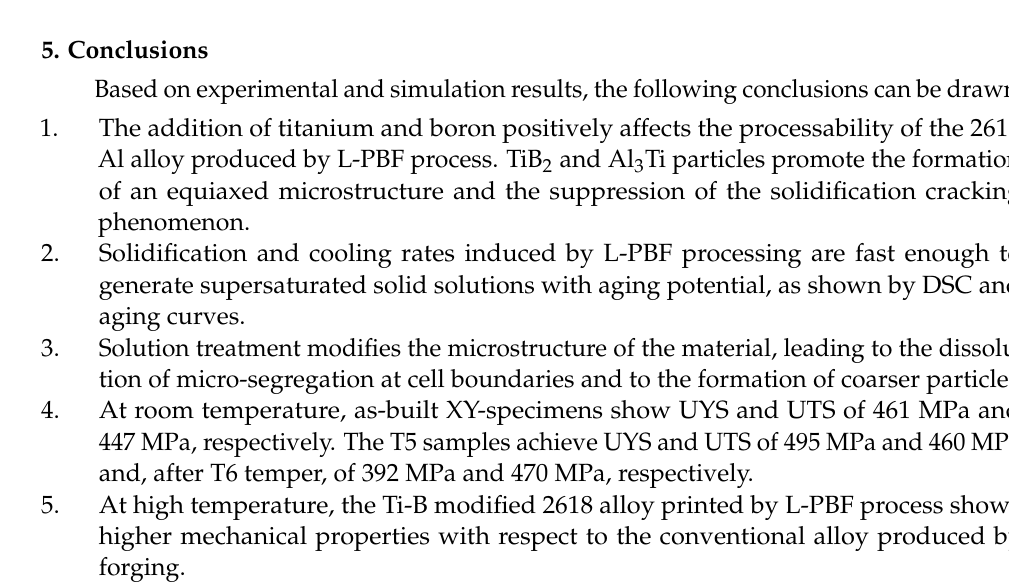
Figure 10. ( a ) UYS vs. Temperature and ( b ) UTS vs. Temperature plots of conventional and Ti-B modified 2618 alloys